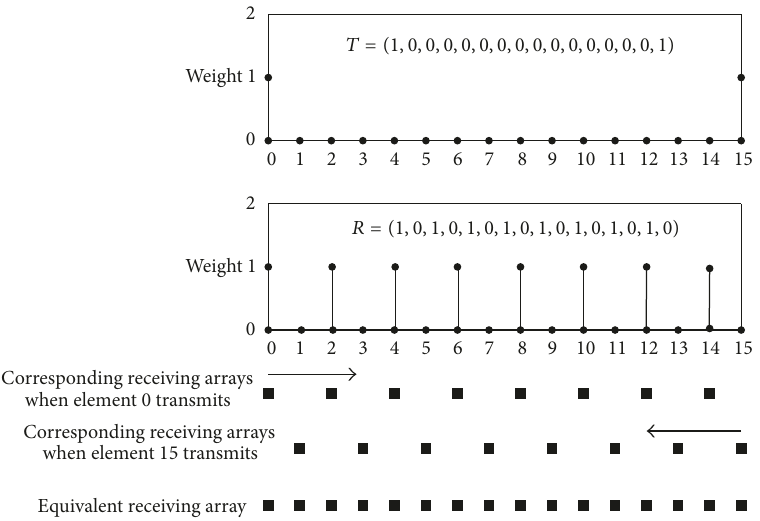
Figure 5: “2-transmitter 8-receiver” transmitter-receiver array and the equivalent receiving array.